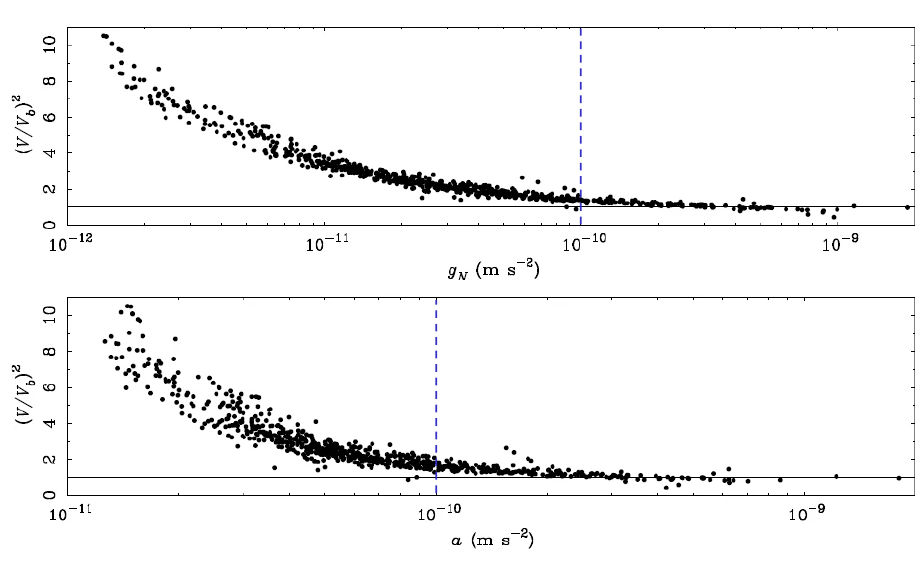
Figure 2. The mass discrepancy–acceleration relation (MDAR) represented as the squared ratio between the total ( V ) and the baryonic ( V b ) velocities as a function of the Newtonian acceleration due to baryonic matter, g N ( top panel ) and the total acceleration a ( bottom panel ). We can clearly see that the mass discrepancy is observed from accelerations smaller than a 0 (cid:39) 10 − 10 m s − 2 (indicated in the figure as a vertical blue dashed line, for reference). The ( V / V b ) 2 − a relation shows a slightly larger scatter than the ( V / V b ) 2 − g N relation. The black dots represent hundreds of individual resolved data points belonging to the rotation curves of about one hundred spiral galaxies. The black solid line ( V / V b ) 2 = 1, showing the no mass discrepancy case, is illustrated as a reference in both panels. The figure is re-adapted from Figure 10 in